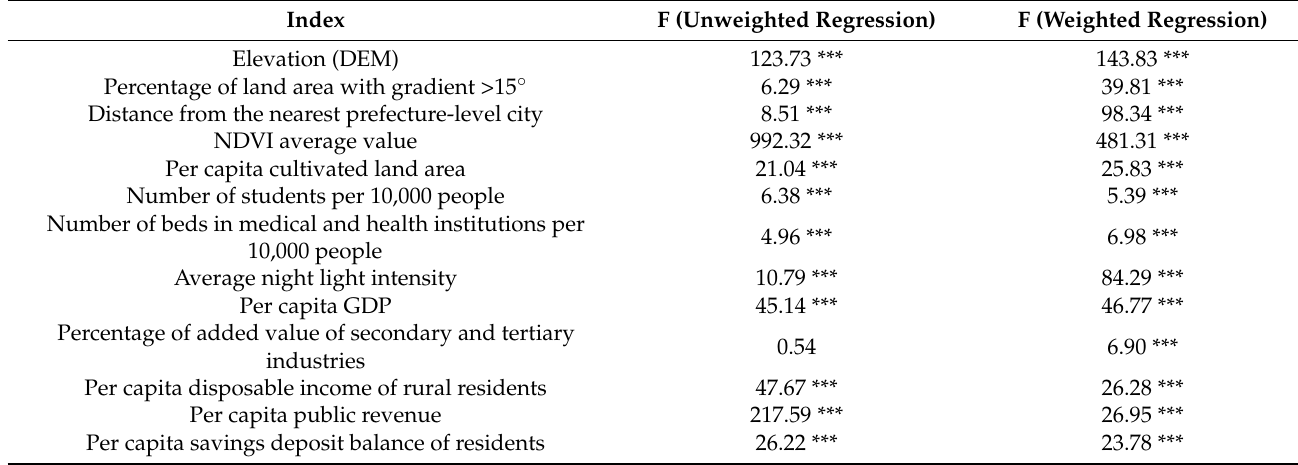
Table 3. F-test of the PI.